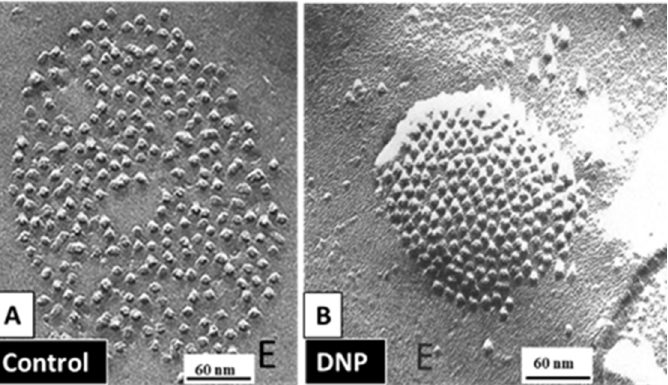
Figure 13. Freeze-fractured gap junctions (E face) of crayfish lateral giant axons fixed in coupled ( A ) or uncoupled ( B ) conditions. Uncoupling was caused by treatment with the metabolic inhibitor dinitrophenol (DNP). With DNP treatment, the channels’ arrays switched from loose ( A ) to tightly (hexagonal) packings ( B ), as the center-to-center spacing between channels decreased from ~200 Å ( A ) to <170 Å ( B ). Adapted from ref. [128].